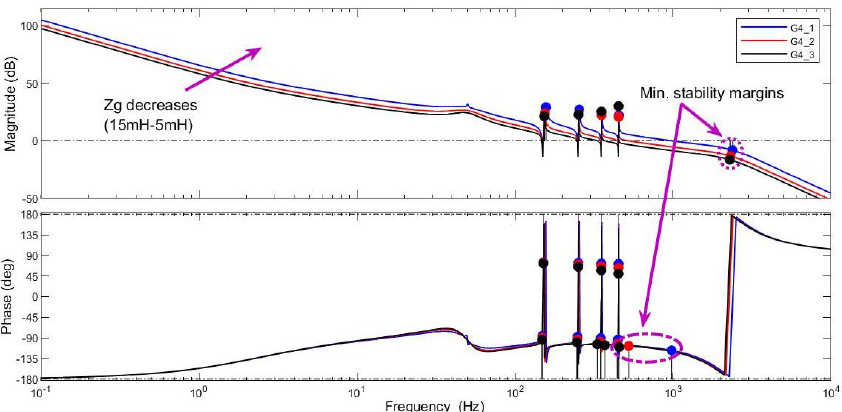
Figure 11. Open loop response of grid tied inverter with proposed adaptive hybrid control technique. The minimum stability margins are also